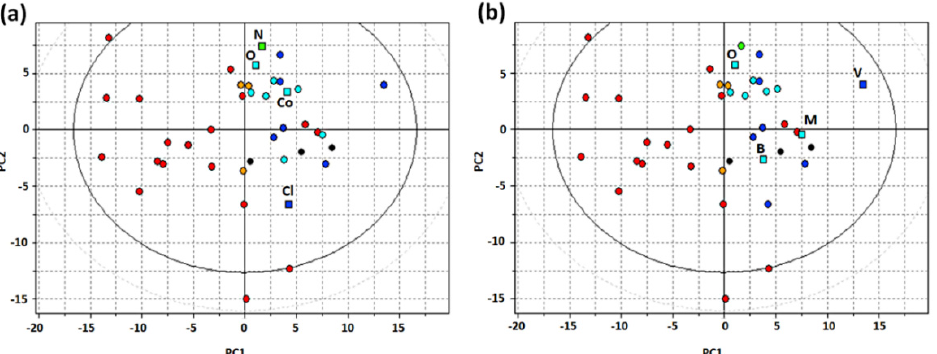
Figure 2. PCA t1-t2 score plot for substrates and non-substrates of the proton-antiporter using VolSurf+ descriptors (G, blue circles; M-H, cyan circles; M-L, green circles; W, orange circles, N-S, red circles): ( a ) Selection of the four substrates used for the generation of pharmacophore P1 (squares: N = naloxone, O = oxycodone, Co = cocaine, Cl = clonidine); ( b ) Selection of the four substrates used for the generation of pharmacophore P2 (squares: O = oxycodone, B = brimonidine, M = methadone, V = verapamil).